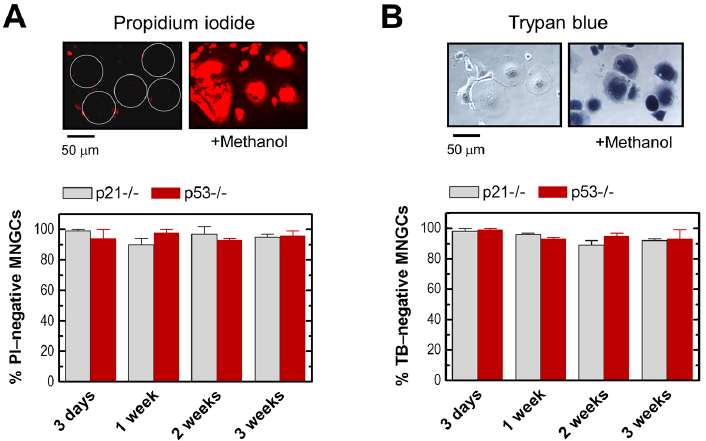
Figure 4. ( A ) Viability of MNGCs created in HCT116p53 − / − cultures at seven days after radiation exposure (8 Gy), evaluated by the PI-exclusion assay. The two images were taken from the same field, before (left image) and after (right image) addition of methanol to the culture medium to permeabilize the cells. Circles mark viable giant cells. The lower panel shows quantitative data for HCT116p53 − / − and HCT116p21 − / − cultures at different times post-irradiation. Bars, SE; ( B ) Viability of the same cultures evaluated by the TB-exclusion